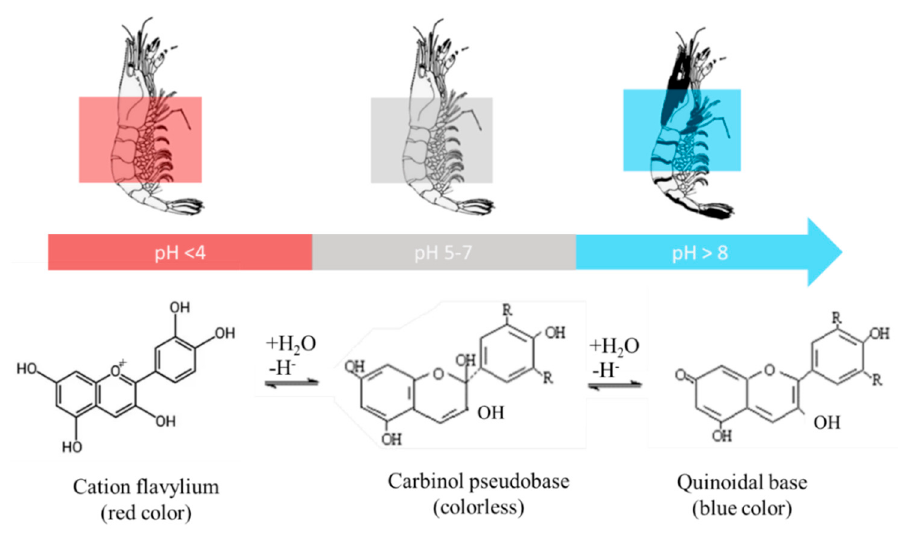
Figure 5. Mechanism of color change in pH − sensitive anthocyanins to monitor shrimp freshness (adapted from Zhao et al. 2022 [106] and You et al. 2000 [102]).